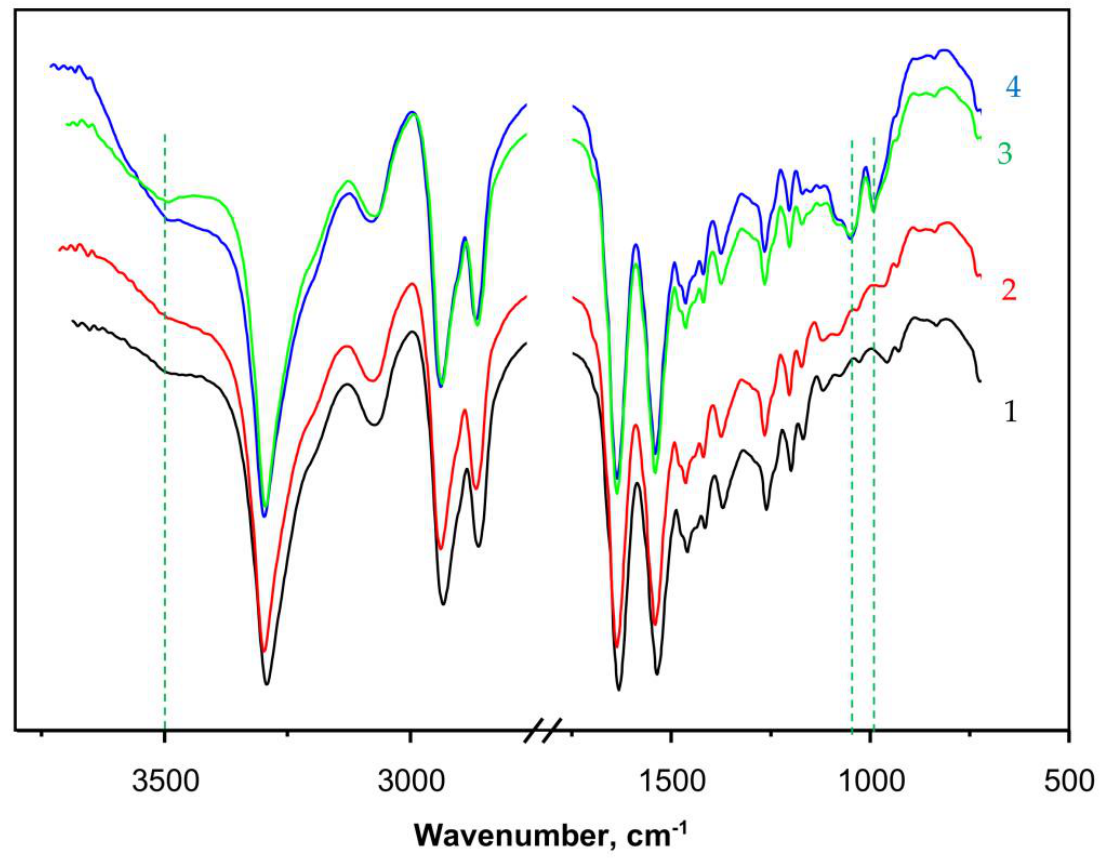
Figure 5. FTIR spectra with ATR of: 1—PA6 MP; 2—PAiH; 3—NF GH/PA; 4—NF G/PaiH. PaiH = HPR adsorbed on PA6 MP; ATR = Attenuated Total Reflection. The dashed lines indicate the ap- pearance of peaks originating from the NF component. For more details, see the text.